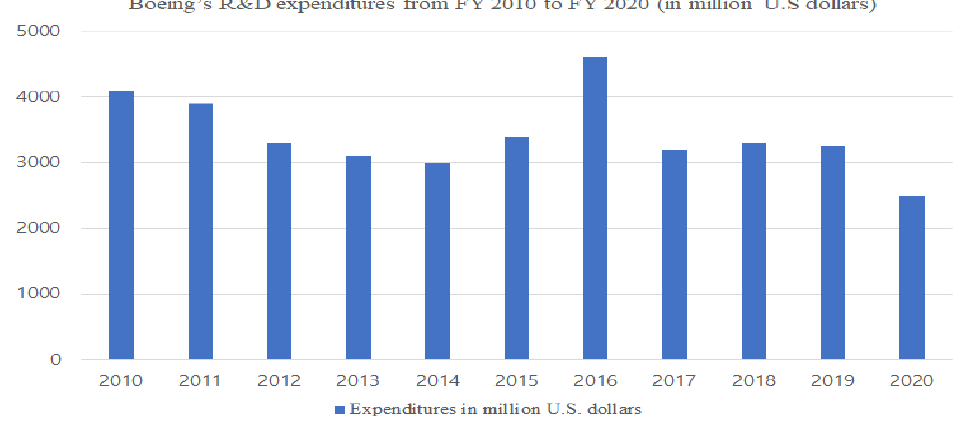
Figure 3. Boeing’s R&D expenditures from FY 2010 to FY 2020. Source. Statista (2021).